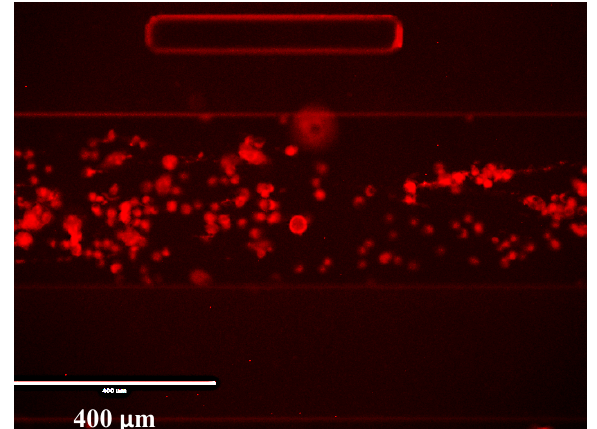
Figure A8. Dark field microscope image of cells exposed to DPBS after 60 min.